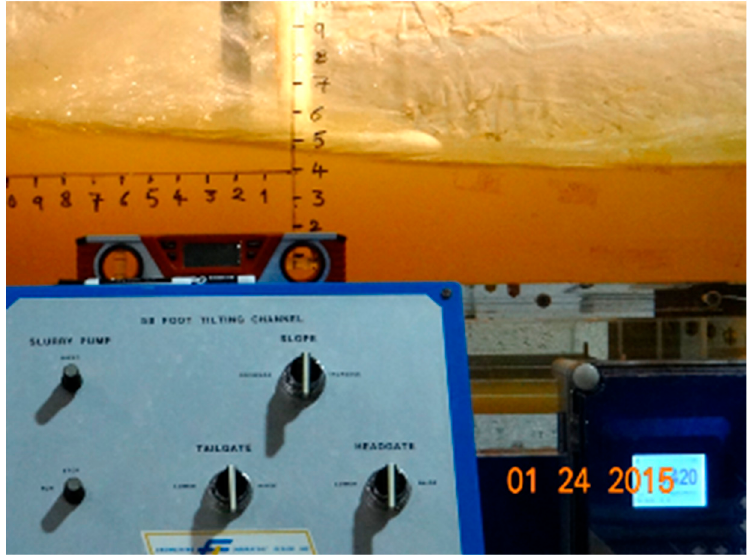
Figure 8. Bulbous pier spraying problem.